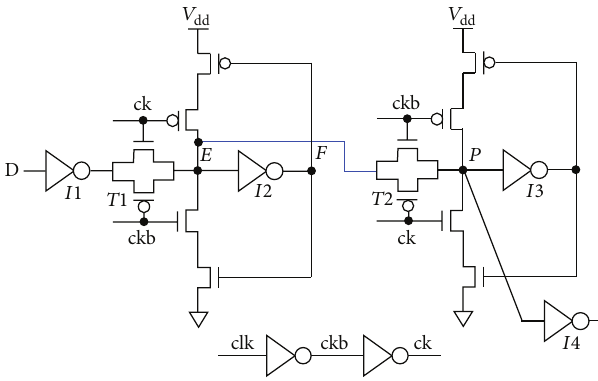
Figure 5: Proposed transmission gate direct path FF